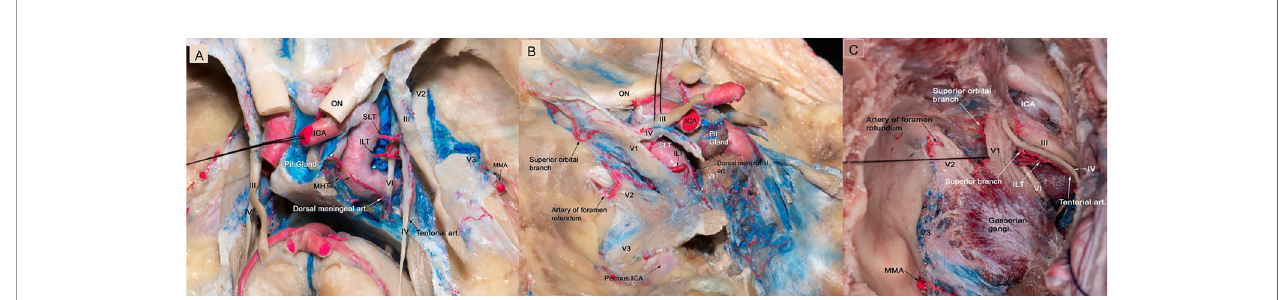
FIGURE 1 | (A) Microscopic view of the roof and lateral wall of the CS in a colored silicone-injected human cadaveric specimen showing the branches of the intracavernous ICA supplying the intracavernous CN. The dural covering of the right cavernous sinus has been removed to expose the cavernous sinus contents. The MHT originating from the proximal cavernous segment of the ICA, in this specimen a double trunk is present, the main trunk is giving off the dorsal meningeal artery, which passed posteriorly through the CS to supply the clival dura and abducens nerve within Dorello ’ s canal. The ILT arose from the lateral side of the midportion of the horizontal segment of the intracavernous ICA, and is directed inferiorly. It provides blood supply to CN III, CN IV, middle and distal segments of CN VI. The SLT arises from the supero-lateral aspect of the horizontal segment of the intracavernous ICA, courses superiorly, and then runs adjacent to CN III and IV as they run through the dura and provide them with blood supply. In this specimen, the tentorial artery is originating from the ILT, which courses lateral to the tentorium to contribute to the blood supply of the interdural segment of the trochlear nerve. (B) The dura of the lateral wall of the left CS has been removed to show the intracavernous CNs and terminal branches of the ILT. The ILT giving off the superior orbital branch, which goes through the superior orbital fi ssure and supplies blood to the distal segments of all CNs passing through the superior orbital fi ssure. The ILT then courses laterally over V1 and gives off the artery of the foramen rotundum, which supplies the distal segment of V2. (C) Microscopic view of the lateral wall of left cavernous sinus showing terminal branches of the ILT. The ILT giving off the superior orbital branch, and the superior branch. It then courses laterally under V2 segment and gives off the artery of foramen rotundum. The ILT also gives rise to tentorial branch which is supplying CN IV. CN, cranial nerve; CS, cavernous sinus; ICA, internal carotid artery; ILT, inferolateral trunk; MHT, meningohypophyseal trunk; SLT, superolateral